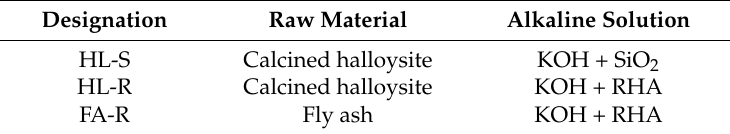
Table 1. Composition and designation of the dense